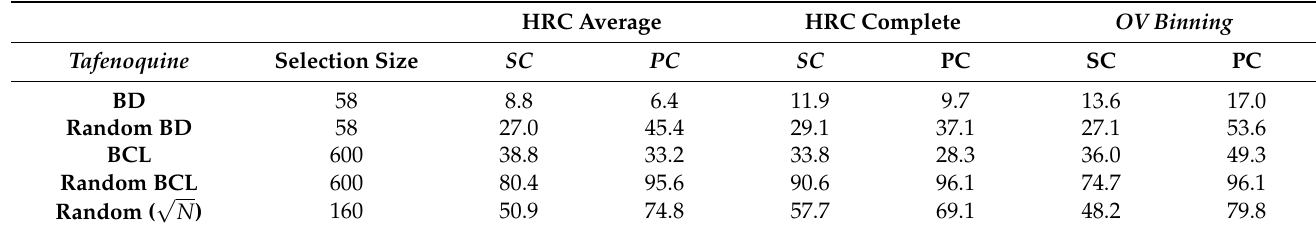
√ N clusters for Tafenoquine analogs.